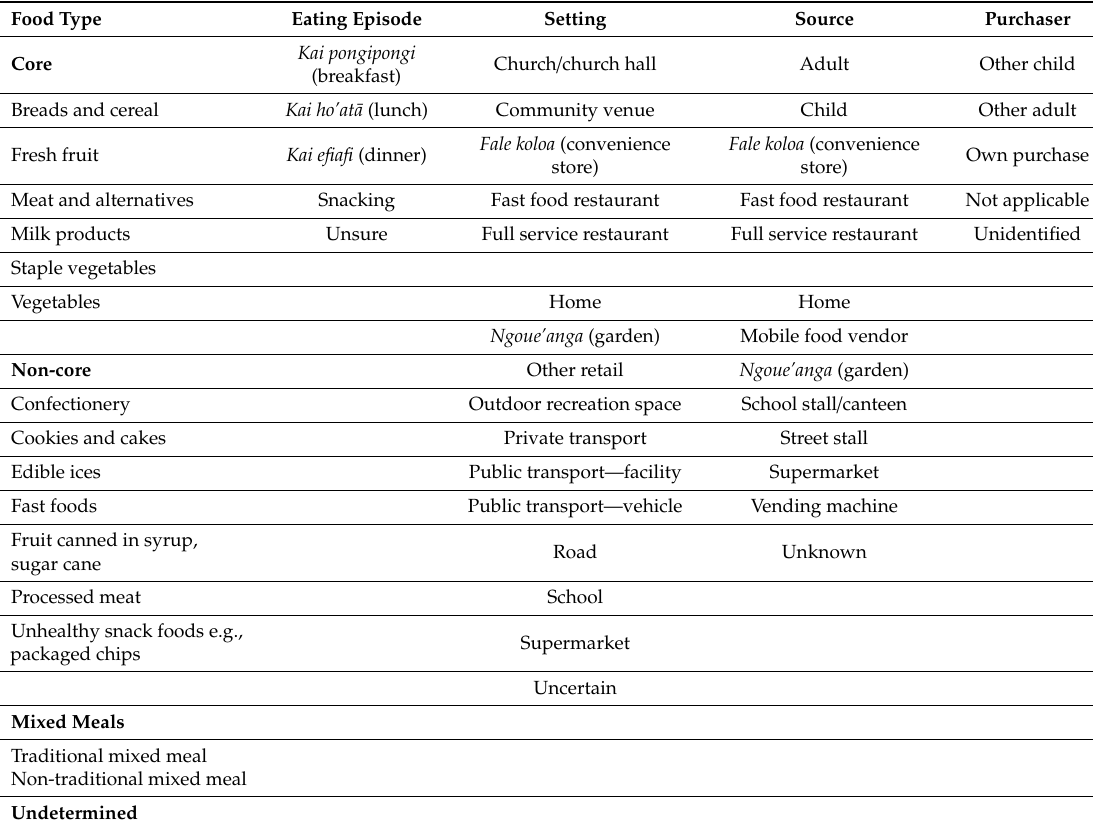
Table 1. Kids’Cam Tonga FOODS coding